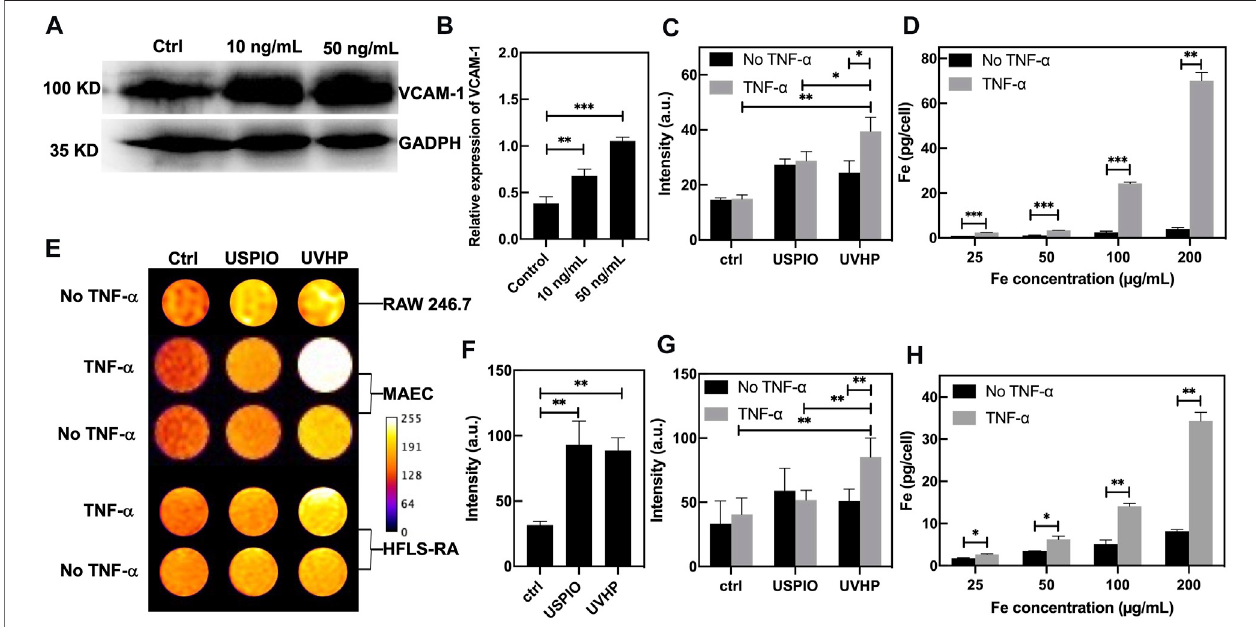
FIGURE 4 | TNF- α – stimulated MAEC high expression of VCAM-1 and cell targeting assay. (A) Western blot of MAECs treated with TNF- α (10 ng/mL, 50 ng/mL). MAECs treated with PBS were used as control. (B) Quantitative Western blot analysis of VCAM-1. (C) T 1 -weighted MRI signal values of non – TNF- α – stimulated MAECs and TNF- α – stimulated MAECstreatedwiththeUSPIOandUVHP(bothFeconcentration50 µg/mL). (D) TheTNF- α – stimulated MAECuptakeoftheUVHPwithdifferent concentrations (Fe concentration 25, 50, 100, and 200 µg/mL) for 24 h. No TNF- α – stimulated MAECs were used as control. (E) T 1 -weighted MR pseudocolor images of cells. Raw 264.7 cells treated with USPIO or UVHP (both Fe concentration 50 µg/mL) for 24 h. MAECs treated with USPIO or UVHP (both Fe concentration 50 µg/mL) for 24 h in the presence or absence of TNF- α (50 ng/mL). HFLS-RA cells treated with USPIO or UVHP (both Fe concentration 50 µg/mL) for 24 h in the presenceorabsenceofTNF- α (10 ng/mL).AllcellstreatedwithPBSascontrols. (F) T 1 -weightedMRIsignalvaluesofnon – TNF- α – stimulatedraw264.7cellstreatedwith the USPIO and UVHP (both Fe concentration 50 µg/mL). (G) T 1 -weighted MRI signal values of non – TNF- α – stimulated HFLS-RA cells and TNF- α – stimulated HFLS-RA cellstreatedwiththeUSPIOandUVHP(bothFeconcentration50 µg/mL). (H) TheTNF- α – stimulated HFLS-RAcelluptakeoftheUVHPwithdifferentconcentrations(Fe concentration 25, 50, 100, and 200 µg/mL) for 24 h. Non – TNF- α – stimulated HFLS-RA cells were used as